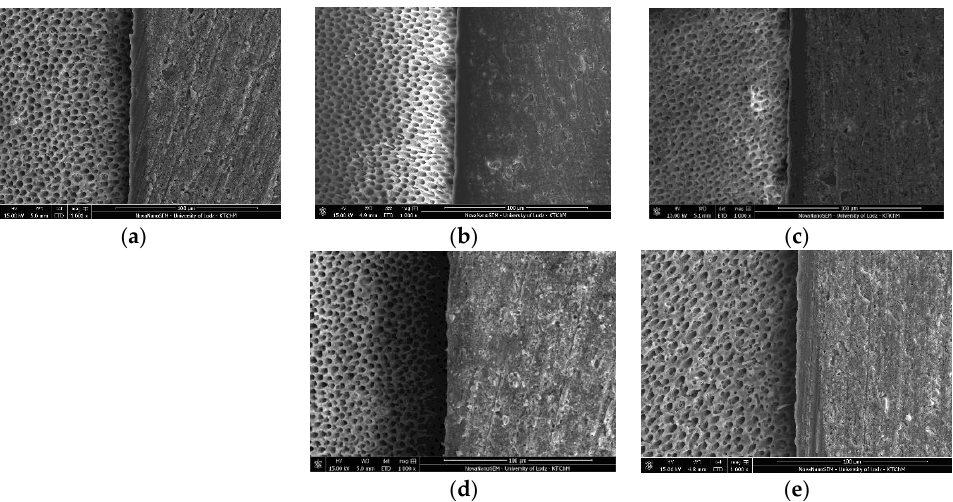
Figure 1. SEM micrographs of dentin specimens treated with Adper Easy One: ( a ) 1A20 (control); ( b ) 2A20; ( c ) 3A20; ( d ) 2A40; ( e ) 3A60; mag. 1000 x.